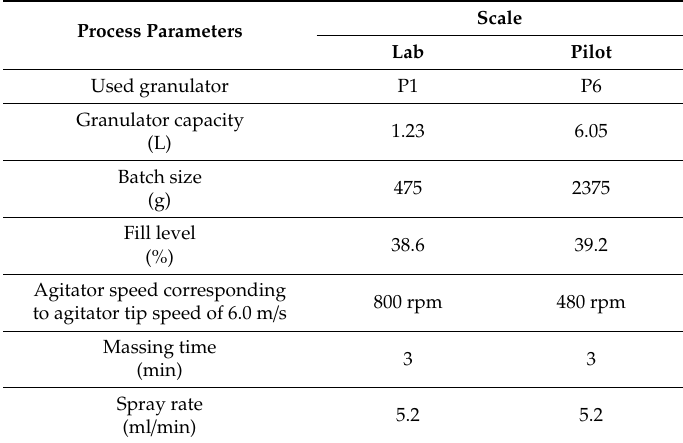
Table 5. Process parameter settings for the scale-up strategy of high-shear wet